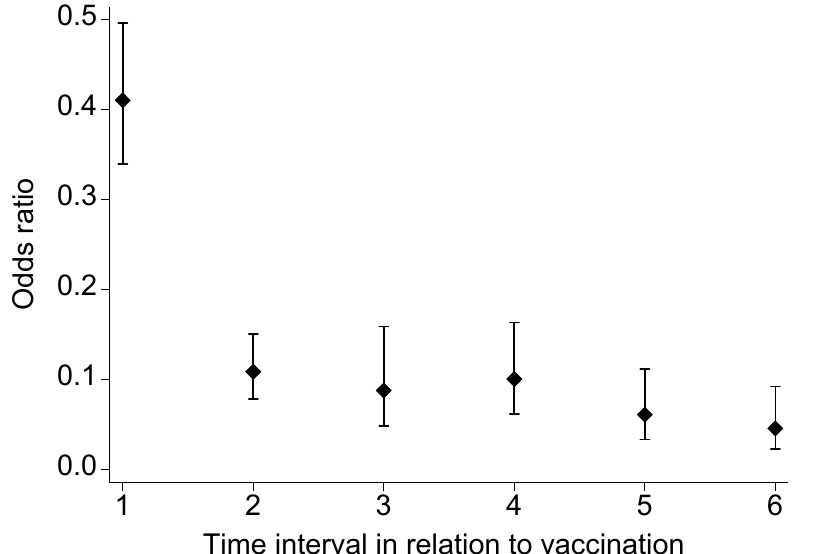
Figure 2. Adjusted odds ratios (1-VE) of requiring intensive care by interval in relation to vaccination from the matched case-control study Note that these results account for temporal trends in variants, NPI and changes in incidence (waves) or susceptible population over time by design (matching by calendar period). Time intervals: 0 = reference group infected prior to vaccination; 1 = those infected between first and second dose; 2 = those infected between the second dose to four months later; 3 = those infected between the fourth to sixth month after the second dose; 4 = those infected between the sixth to ninth month after the second dose; 5 = those infected between the ninth to twelfth month after the second dose; 6 = those infected after the third dose .